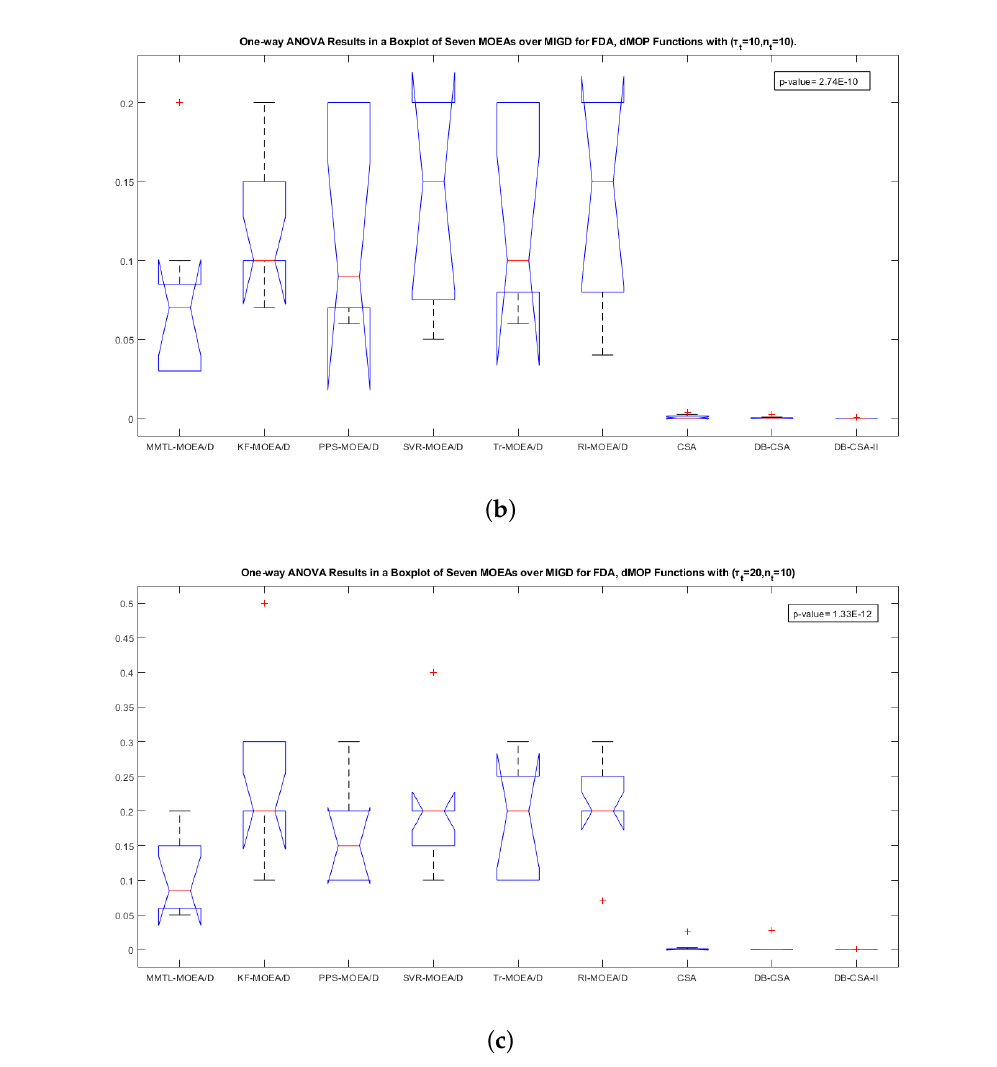
Figure 5. One-way ANOVA Box-plots of 7 MOEAs over MIGD of FDA, dMOP for ( a ) severe with ( τ t = 5, n t = 10), ( b ) moderate ( τ t = 10, n t = 10), and ( c ) slight with ( τ t = 20, n t = 10) environmental changes